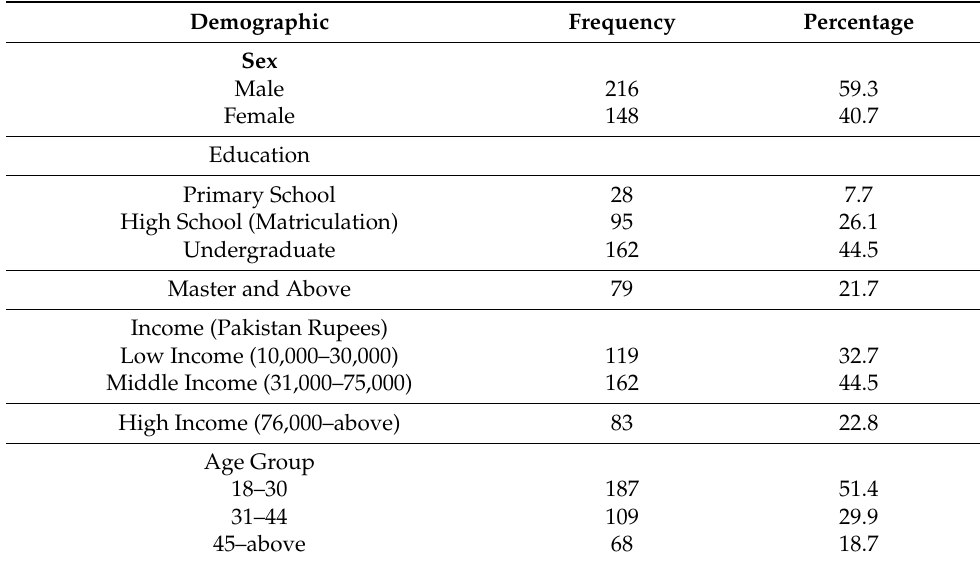
Table 1. Demographic